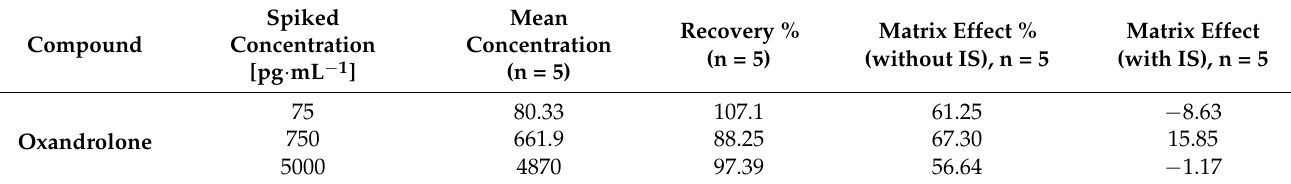
Table 4. Recovery and matrix